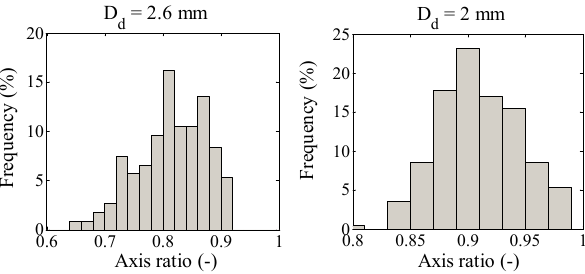
Figure 3. Distribution of axis ratio of drops measured in the BERGAME aerosol chamber over a sample of 200 drops